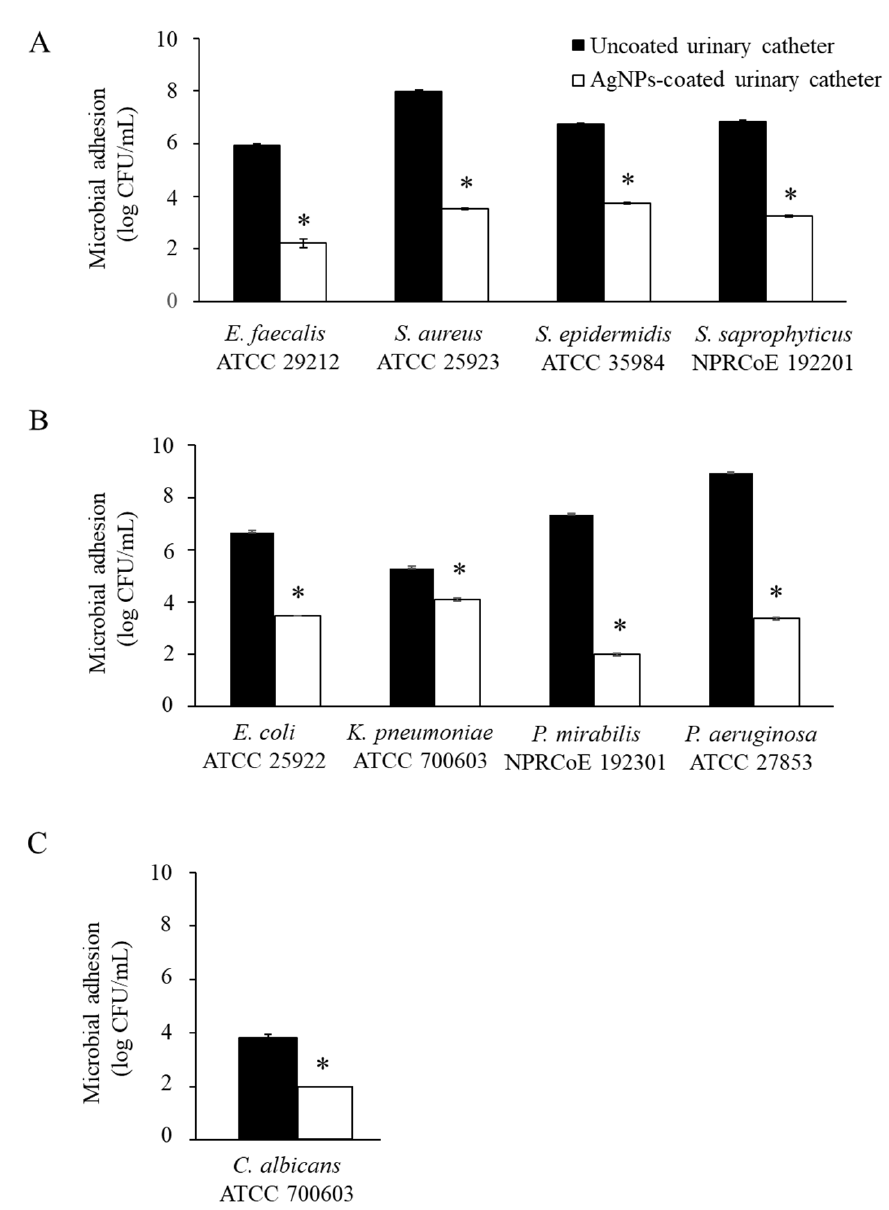
Figure 4. Antimicrobial adhesion following 24 h incubation of uncoated and AgNPs-coated urinary catheters against ( A ) Gram-positive bacteria, ( B ) Gram-negative bacteria, and ( C ) fungi. The values indicate mean ± SD from three independent experiments performed in triplicate, * p < 0.05.